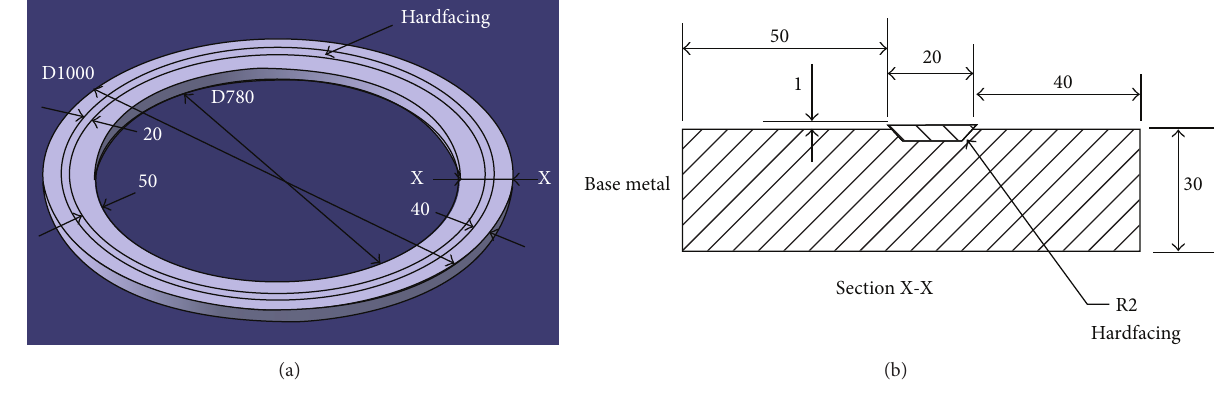
Figure 2: Geometry of the model used in the